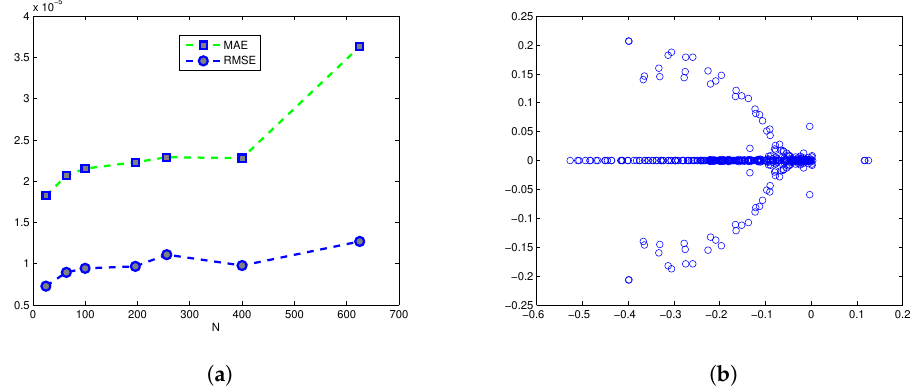
Figure 2. ( a ) Nodes M against MAE and RMSE norms for ns = 20, and ( b ) stability plots of our numerical scheme corresponding to Example 1.